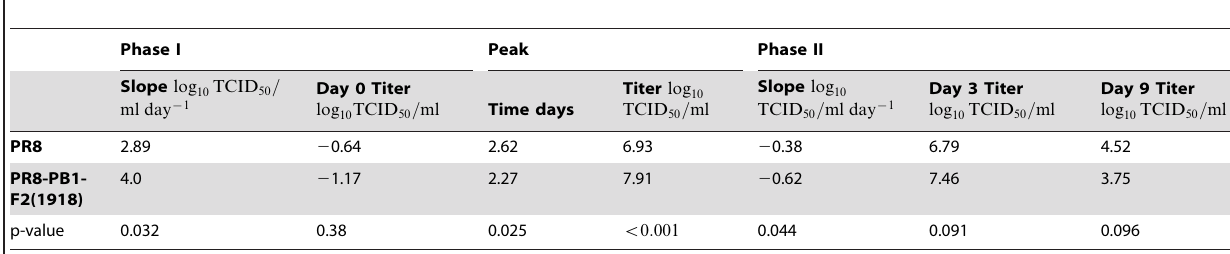
Table 1. Slopes, intercepts, peak times and peak values from linear regression analysis of PR8 and PR8-PB1-F2(1918) lung titers.